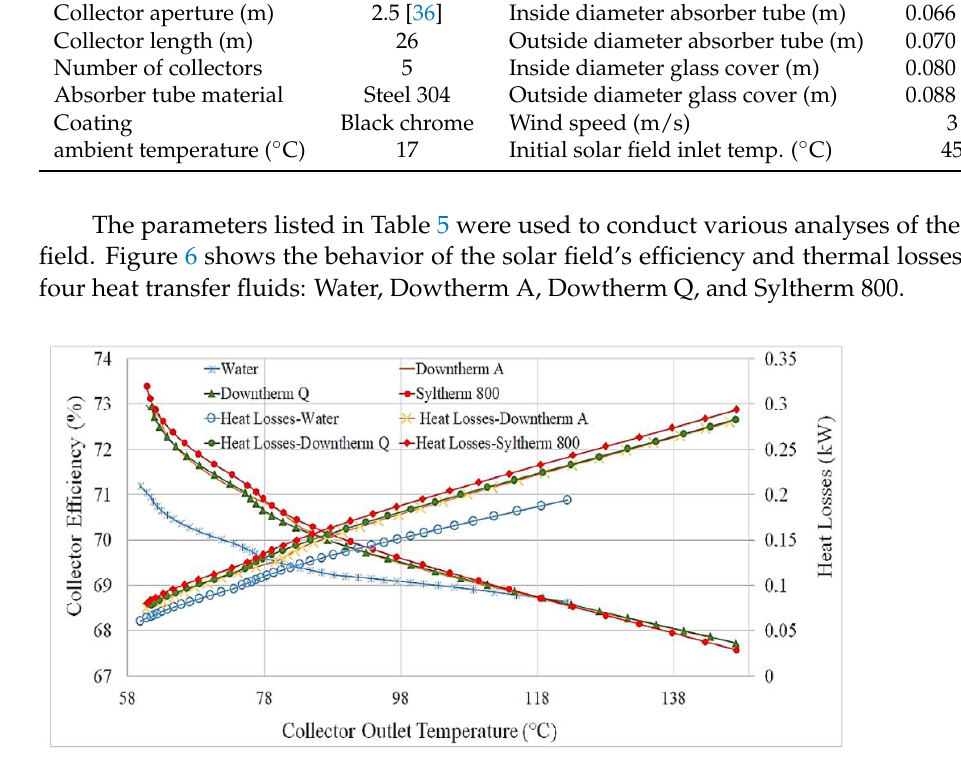
Table 5. Design parameters for the solar field.